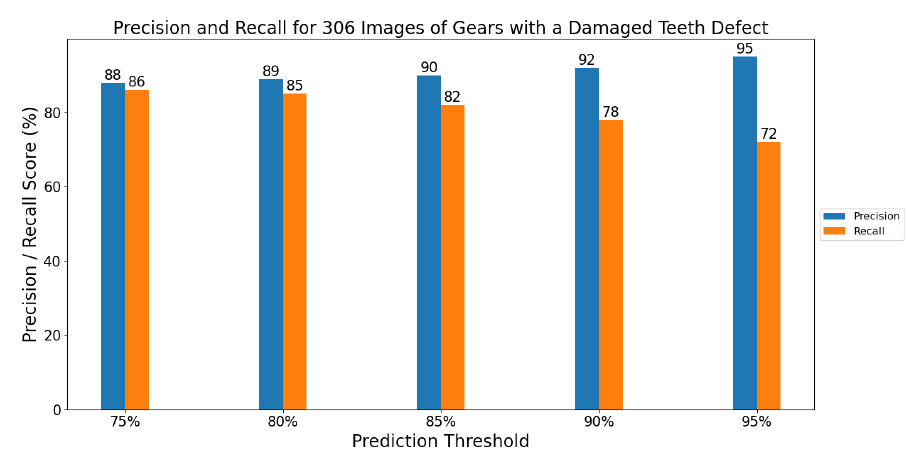
Figure 6. Precision and recall values for 306 images of damaged teeth